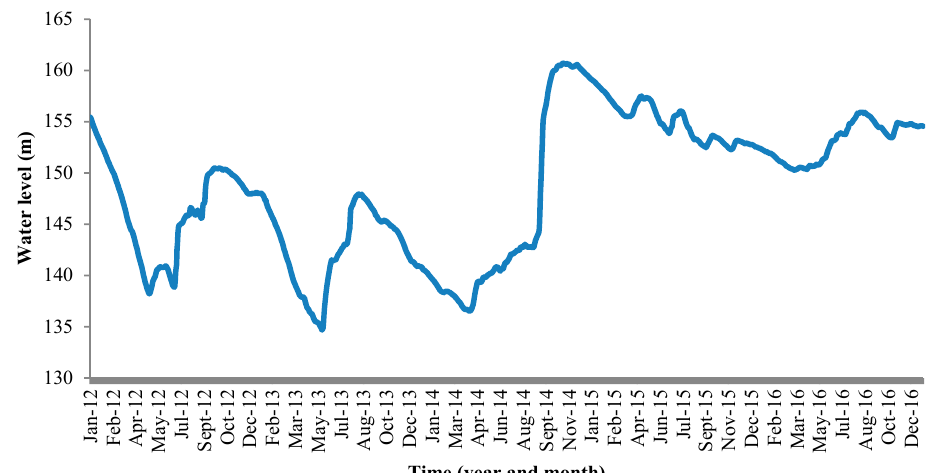
Figure 2. Daily water level changes in the Danjiangkou Reservoir (near the Danjiangkou Reservoir Dam) between 2012 and 2016.